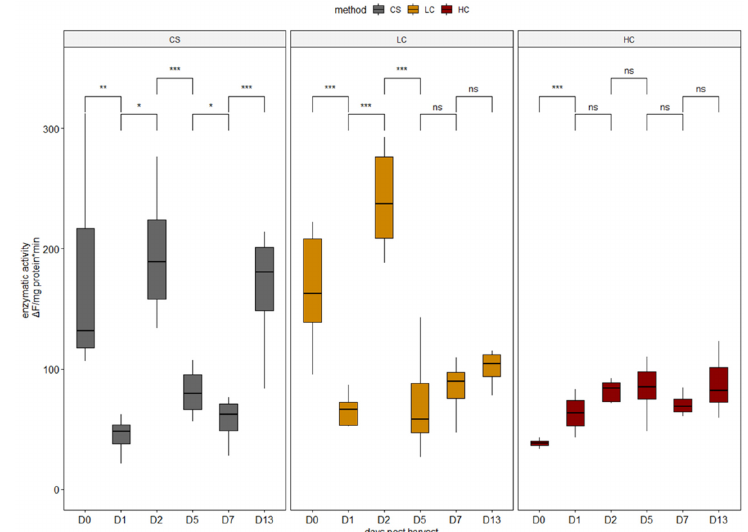
Figure 2. Enzymatic activity of collagenase in all sampling days per harvest method. CS (gray): control group, LC (orange): low current group, HC (red): high current group. Superscripts indicate statistically significant differences between sampling days in each harvest method (ns: p > 0.05, *: p < 0.05, **: p < 0.01, ***: p < 0.001).